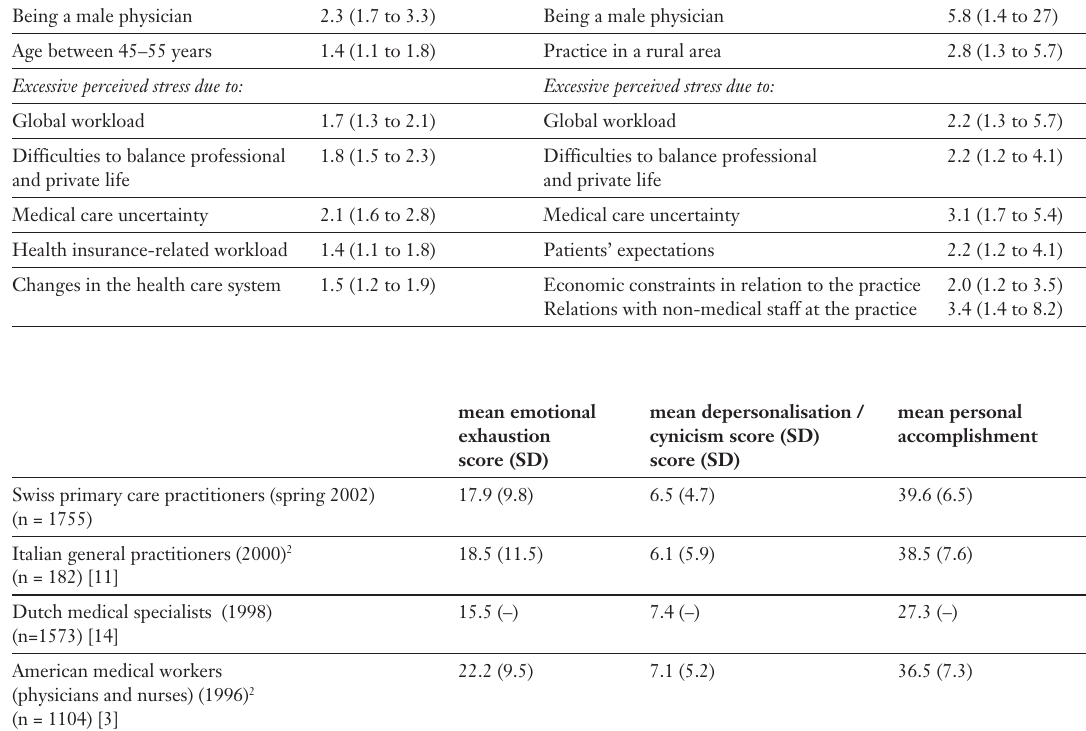
Table 3 Factors associated with a higher risk to report burnout among 1755 Swiss primary care physicians.